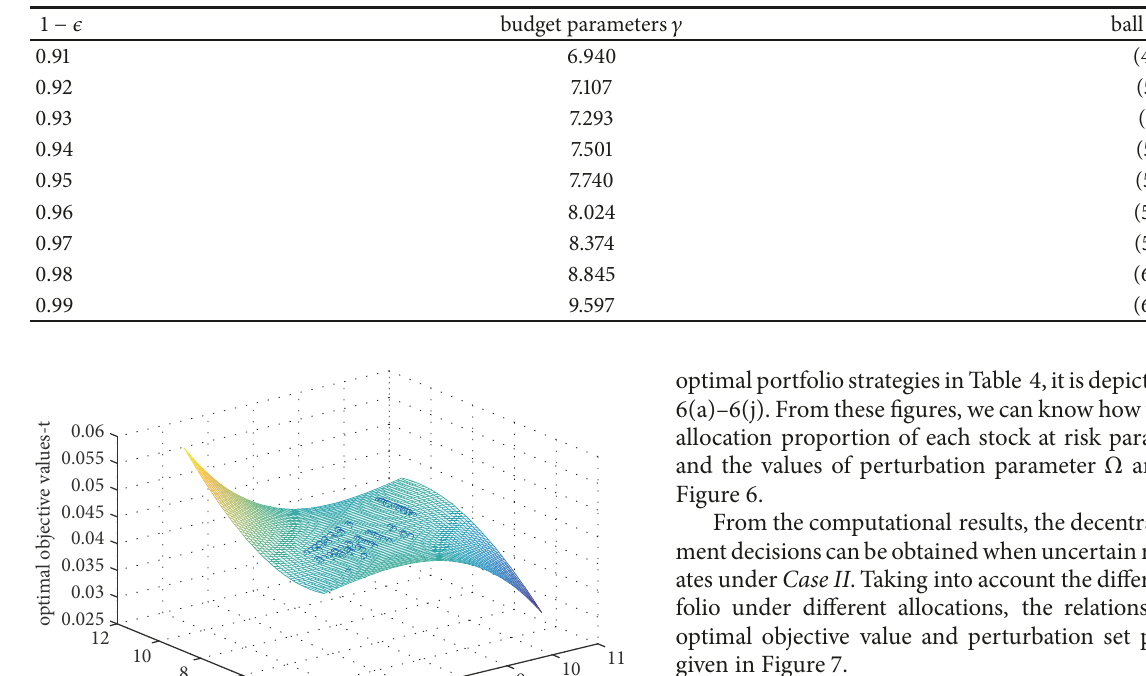
Table 2: The corresponding values between risk parameter 1 − 𝜖 and perturbation parameters Ω, 𝛾 .